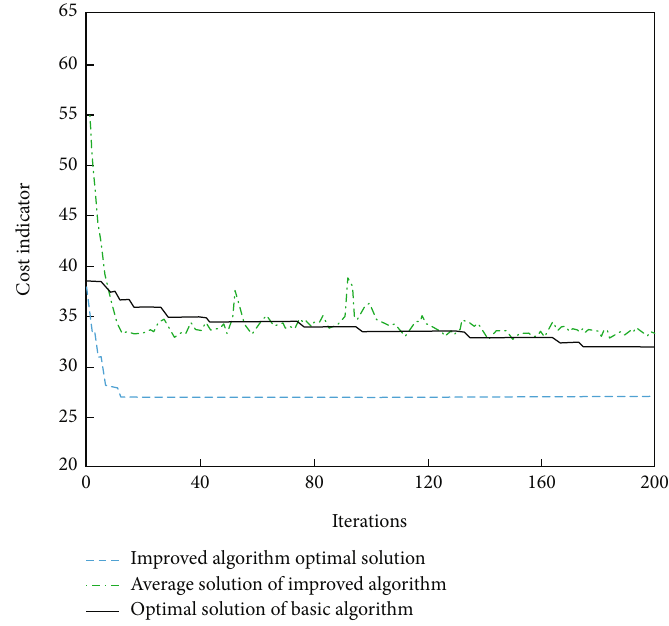
Figure 7: The fi tness change of the improved NSGA-II genetic algorithm in iterations.